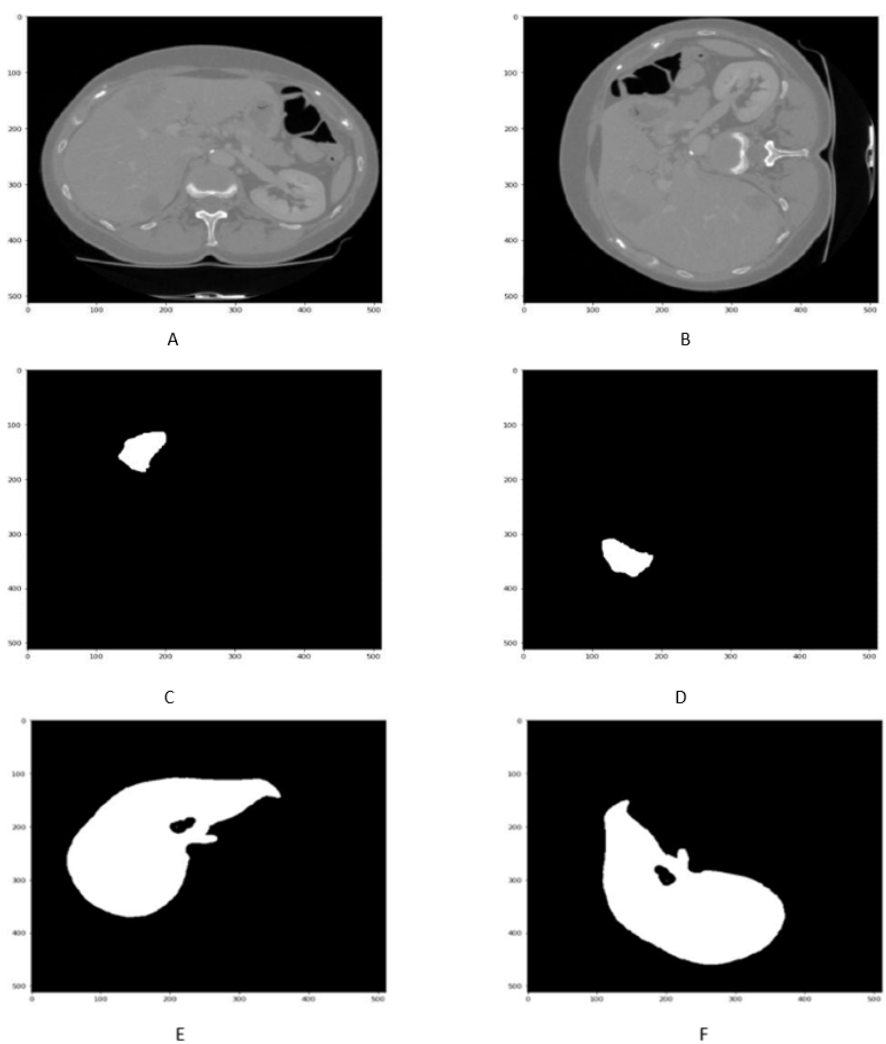
Figure 5. Figure shows that the liver slice and its masks before 90 ◦ in ( A , C , E ) rotation, While liver scan and its masks mask in ( B , D , F ) after